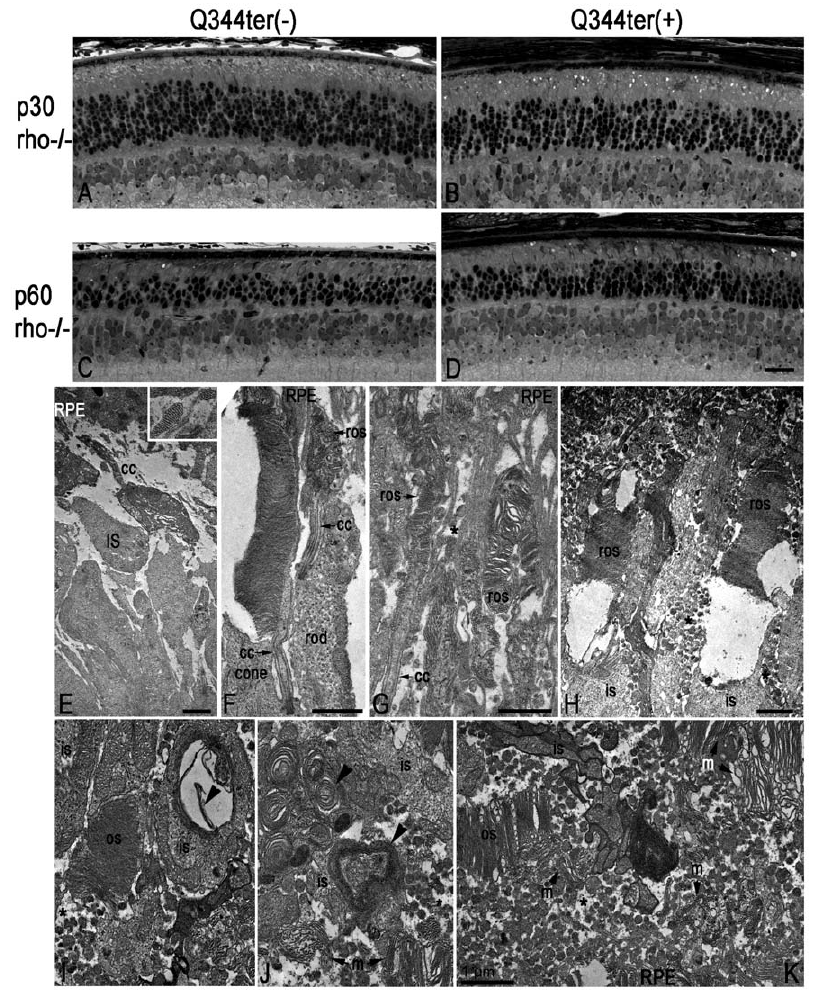
Figure 4. Q344ter transgene does not accelerate retinal degeneration in rho 2 / 2 retinas. As in Figure 2, these images of retinal sections from epoxy-embedded eyecups were taken just above the optic nerve region from Q344ter rho 2 / 2 ( B, D ) and their transgene-negative littermate control ( A, C ) mice at p30 and p60. At both time points, ONL thicknesses appear similar in Q344ter rho 2 / 2 mice and their littermate controls (compare A to B and C to D). Although progressive ONL thinning was observed in both groups, Q344ter does not appear to accelerate degeneration already occurring in rho 2 / 2 mice. Scale bar in D (20 m m) is representative for panels A–D. ( E ) Rho 2 / 2 rod photoreceptors do not elaborate outer segment structures. Instead, membrane tubules are seen (inset). The subretinal space is devoid of vesicular structures. Panels F – H are from p30 Q344ter rho 2 / 2 retinas, and I – K are from p60 Q344ter rho 2 / 2 retinas. ( F ) Short and disorganized rod outer segment can be seen distal to the connecting cilia. A neighboring cone photoreceptor with a much more intact outer segment is shown for comparison. ( G ) The rod outer segments shown here are thinner than normal (compare with Figure 2D). These structures are surrounded by apical processes from the RPE. ( H ) The membranous discs within some outer segment structures appear to be unstable. Numerous vesicular structures are present in the extracellular space (asterisks). ( I-K ) Vesicular structures are present in the interphotoreceptor space of Q344ter rho 2 / 2 retinas. Outer segments containing discs are evident, but they are significantly compromised both in size and organization. Scale bars for E-K=1 m m. Panels I-K are taken at the same magnification. os, outer segment; ros, rod outer segment; is, inner segment; cc, connecting cilium; RPE, retinal pigmented epithelium; m, membranous debris.